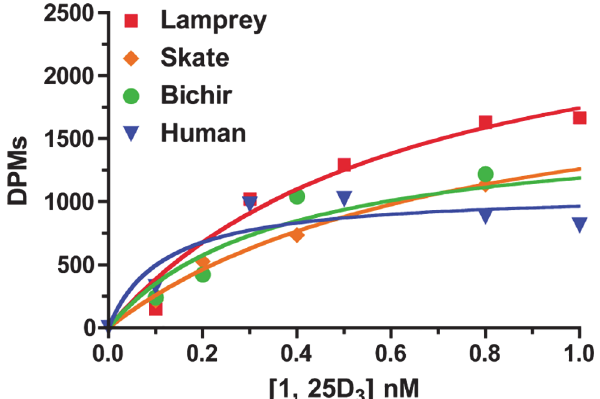
Fig 4. Saturation binding analysis of lamprey, skate, bichir, and human VDR to [ 3 H]-1, 25D 3 . Saturation binding profiles are shown for lamprey VDR (red), skate VDR (orange), bichir VDR (green), and human VDR (blue). Lysates were prepared from transfected Cos7 cells as described in Materials and Methods. Lysates were incubated with 0 – 1.6 nM [ 3 H]-1, 25D 3 for 18 hours at 4°C. Unbound ligand was removed as described. Specific binding values were calculated by subtracting the average non-specific binding counts from the total binding counts. Hyperbolic one-site binding curves were fit using Prism 4. The reported dissociation constant (K d ) in the manuscript for each VDR is the average of three or four separate experiments ± SEM. The graphs shown here are specific binding data from a representative experiment.